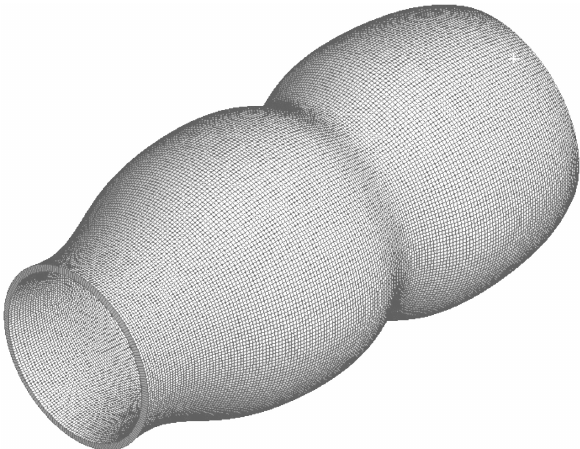
Figure 12. Structured mesh of the rectal wall portion of the colon.